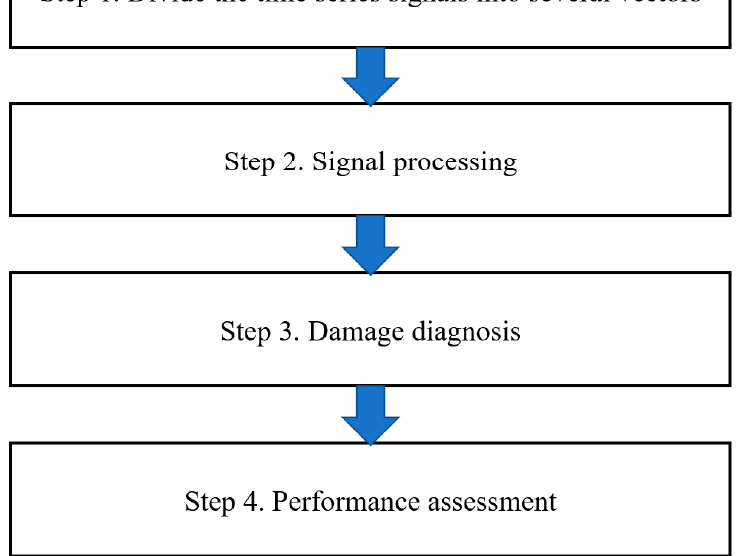
Figure 1. Designed SHM framework.